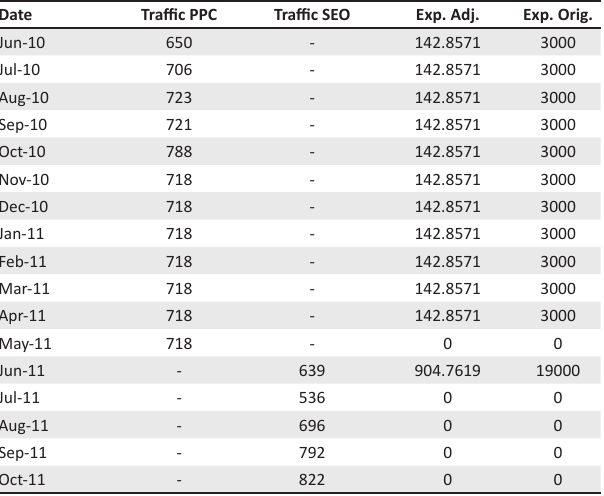
TABLE 1: Comparative traffic during two